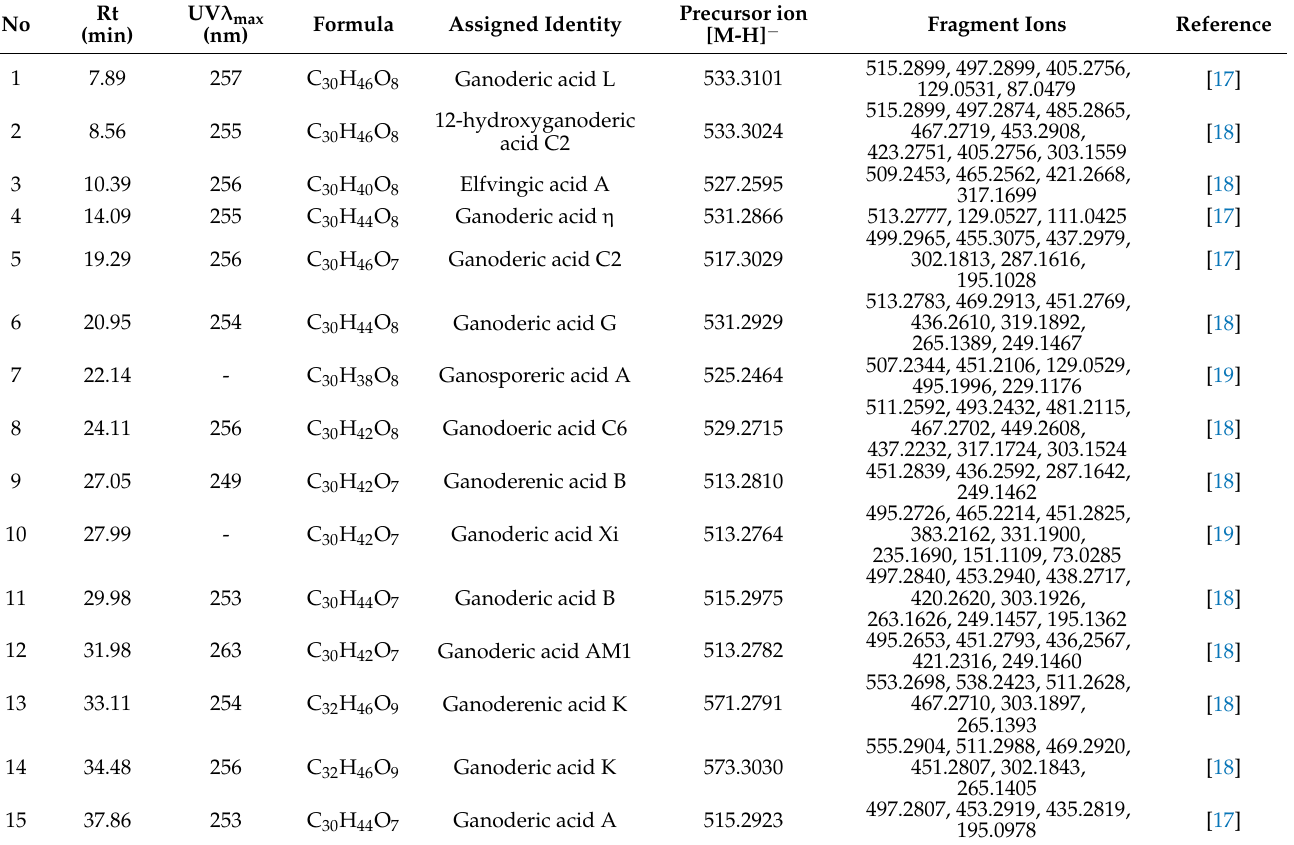
Table 2. Characteristics of twenty-three peaks from the GA identified by HPLC-MS/MS in the negative ionization